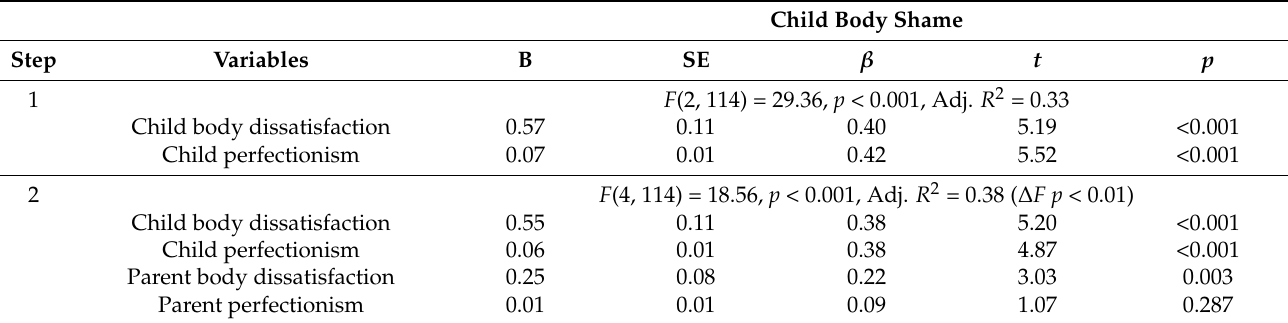
Table 4. Results of hierarchical regression analysis for the prediction of child body shame in Poland. Child Body Shame